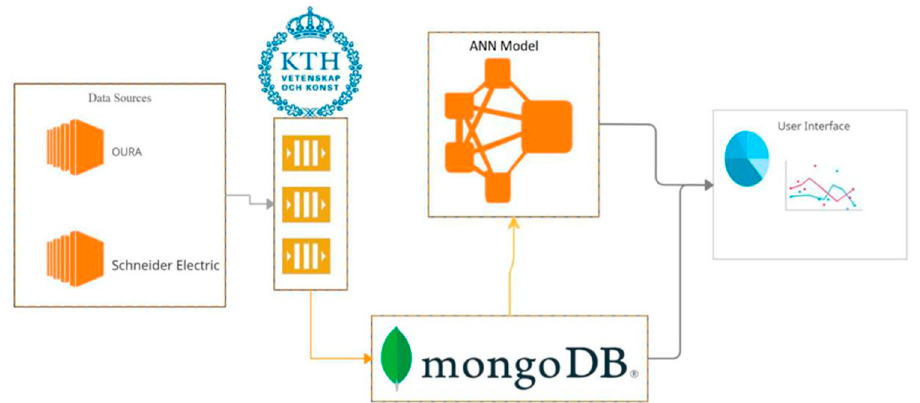
Figure 5. ETL data pipeline during the different stages of this project.